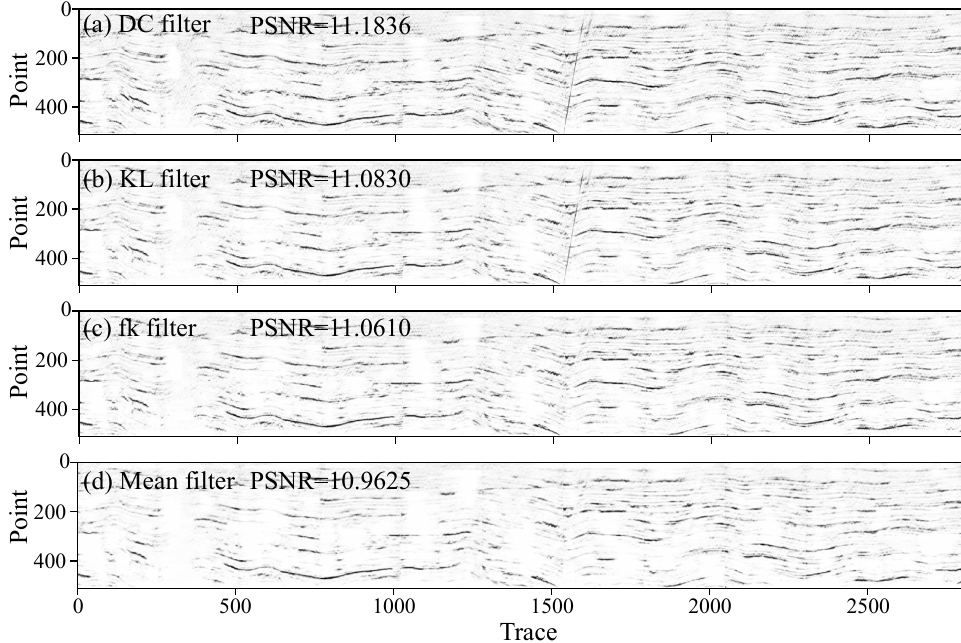
Figure 4. EisNet extraction of internal ice layers after filtering preprocessing: ( a ) DC filtering, ( b ) KL filtering, ( c ) FK filtering, and ( d ) mean filtering.